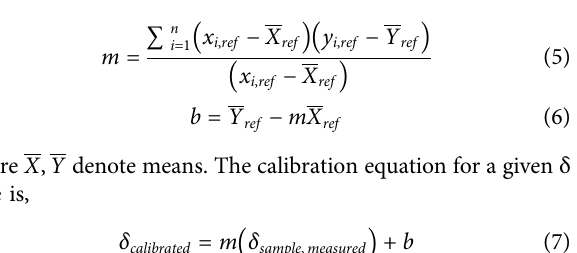
FIGURE 1 | Example of uncalibrated ( “ raw ” ) δ 17 O measurements as reportedbythePicarroL2140- i